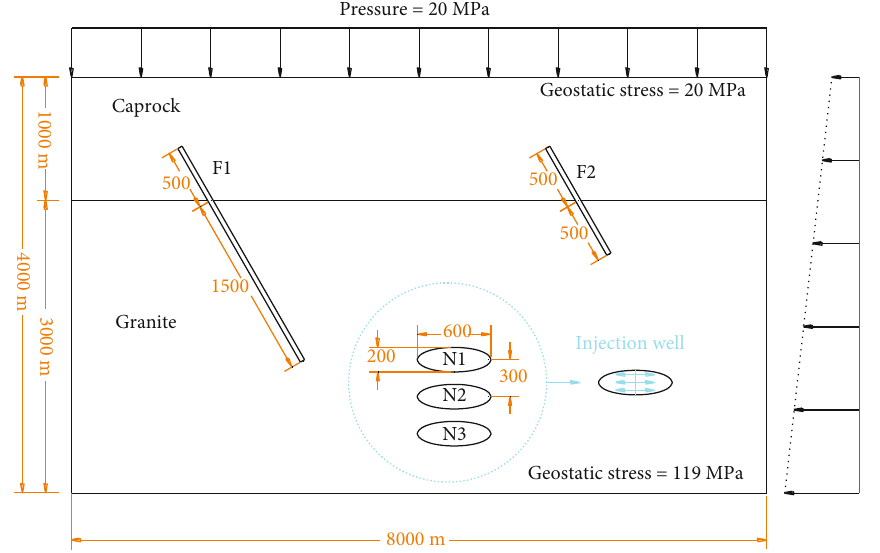
Figure 6: Model of hydraulic fracturing in HDR EGS engineering. Table 1: Physical parameters of the rock